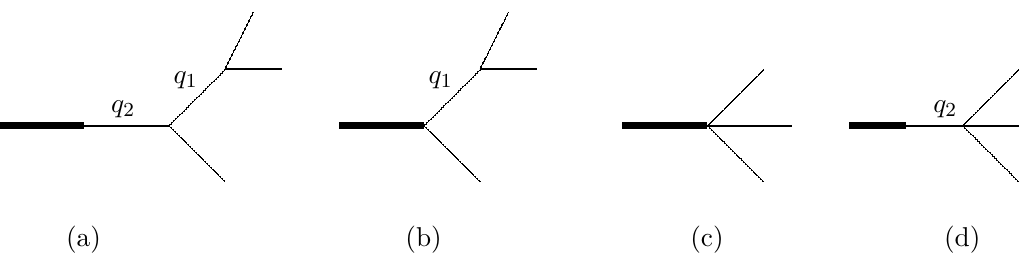
Figure 10 . This figure shows four Feynman diagrams contributing to the disk amplitude with one external closed string and three external open strings. We have not displayed diagrams that differ from each other by permutation of external states. As usual, q 1 and q 2 represent the sewing parameters of the corresponding open string